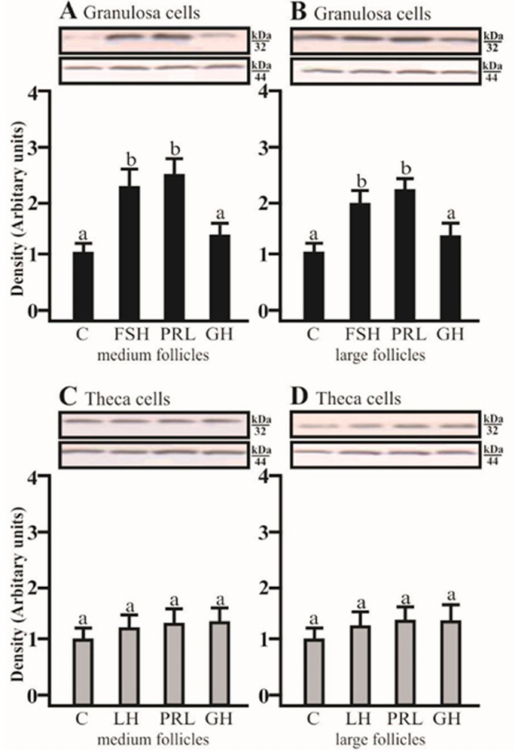
Figure 2. The changes in the expression of AQP5 (kDa 32) protein in porcine Gc and Tc obtained from MF and LF after 24 h incubation in the absence (C) or presence of follicle-stimulating hormone (FSH), luteinizing hormone (LH), prolactin (PRL), and growth hormone (GH). The samples were subjected to Western blot analysis and normalized to the expression of β -actin (kDa 44), ( A , B ) in the Gc and ( C , D ) Tc. Values are expressed as means ± S.E.M from five separate experiments, each performed in triplicate ( p < 0.05 compared with controls). Statistically significant di ff erences between treatments are indicated by di ff erent letters (a, b). C: